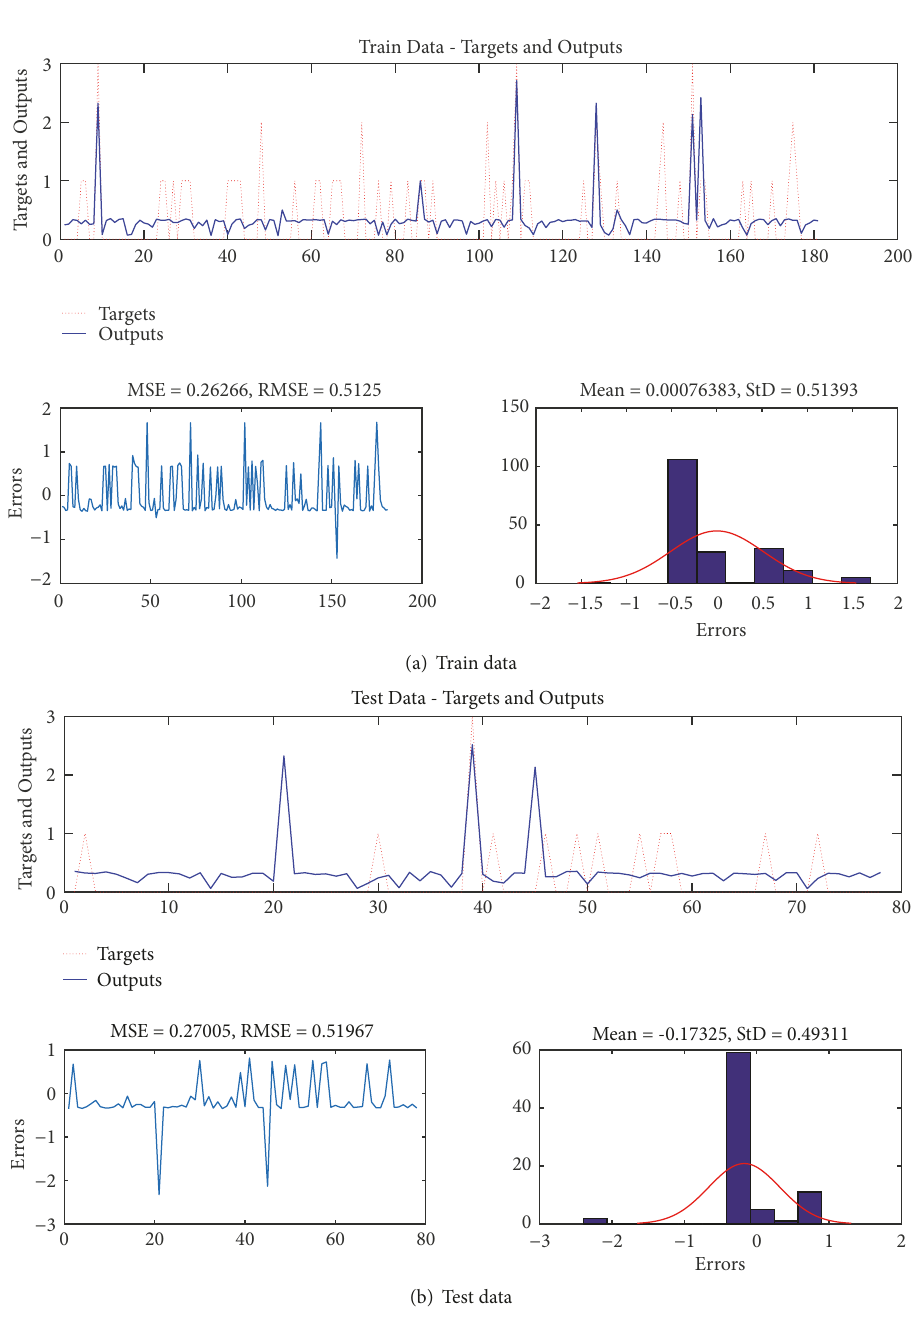
Figure 3: (a) General structure of a typical fuzzy logic system and (b) Sugeno-type fuzzy inference